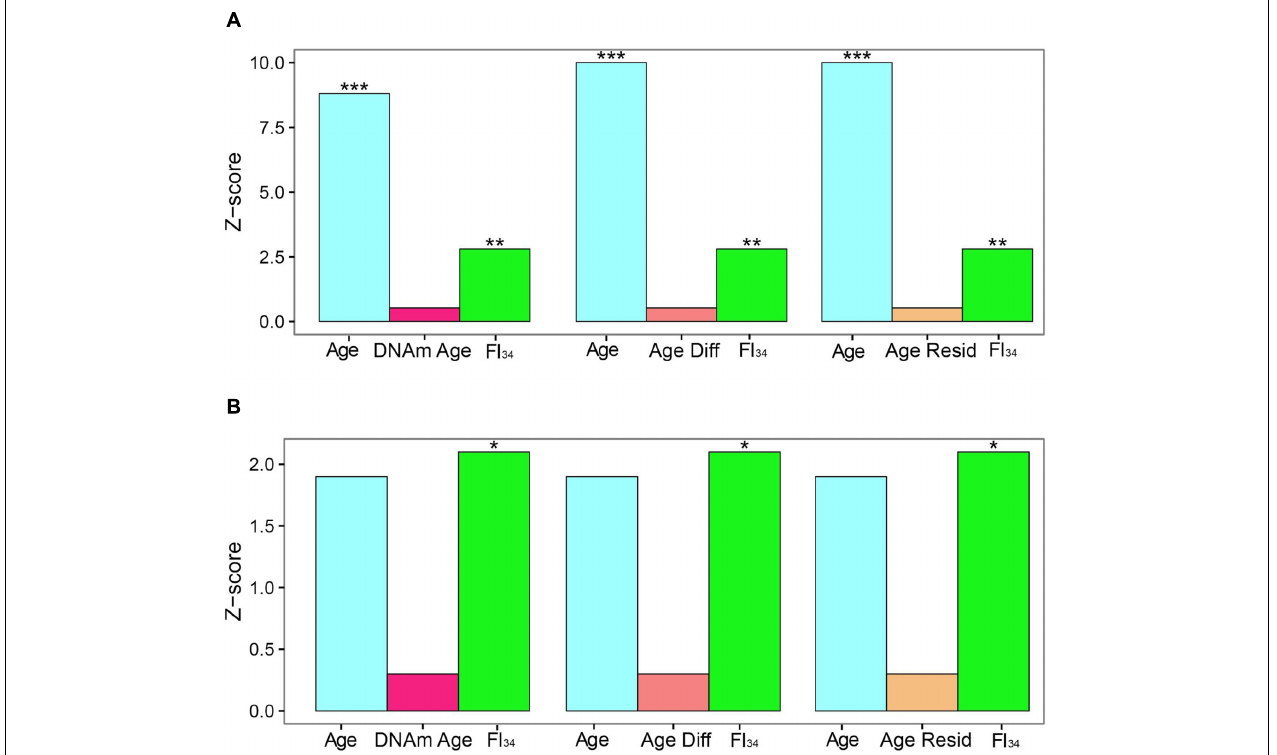
FIGURE 2 | Comparison of effect sizes for hazards of death. Cox proportional hazards regressions were applied to the survival data of 262 subjects ages 60–103 and are presented as Z scores. Age, FI 34 , DNA methylation age (DNAm Age), Age Acceleration Difference (Age Diff), and Age Acceleration Residual (Age Resid) are the covariates. (A) All subjects, (B) nonagenarians ( N = 161). ∗ p < 0.05; ∗∗ p < 0.01; ∗∗∗ p < 0.001. This figure has been adapted from Kim et al. (2017) under the Creative Commons Attribution 4.0 International License